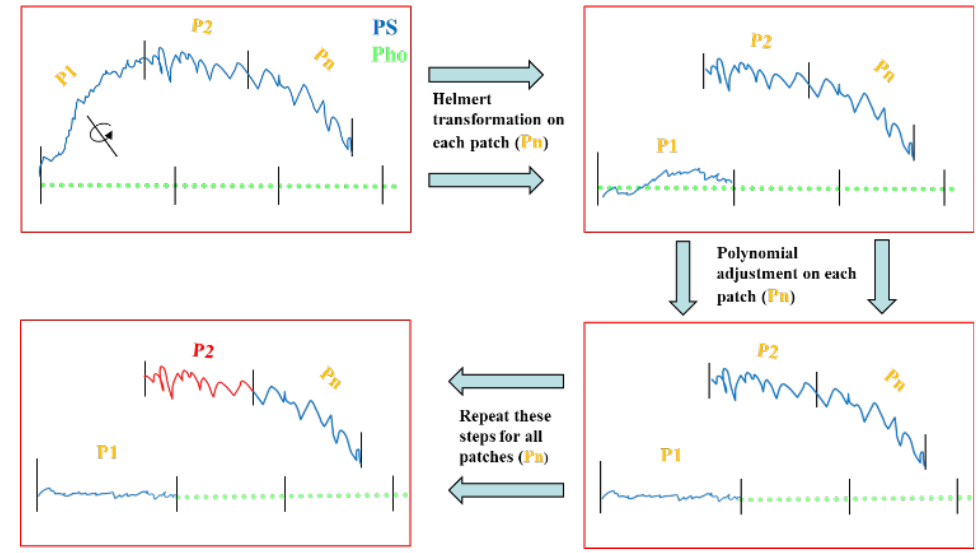
Figure 7. Schematic view of the pricewise shape correction approach (Method C).